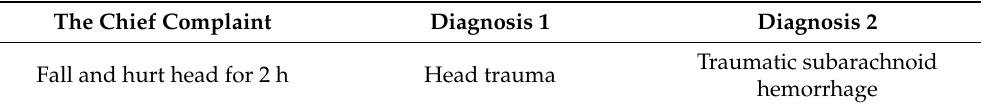
Table 6. One example of a medical record.